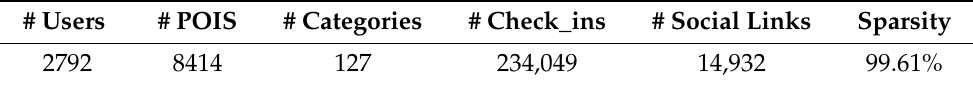
Table 2. Statistics of